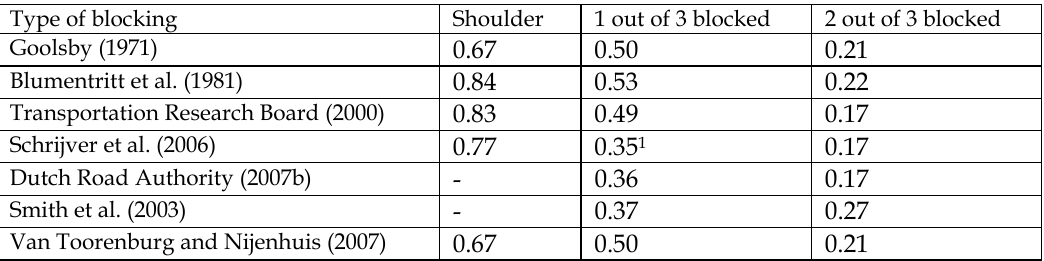
Table 1. Overview of the remaining capacities Type of